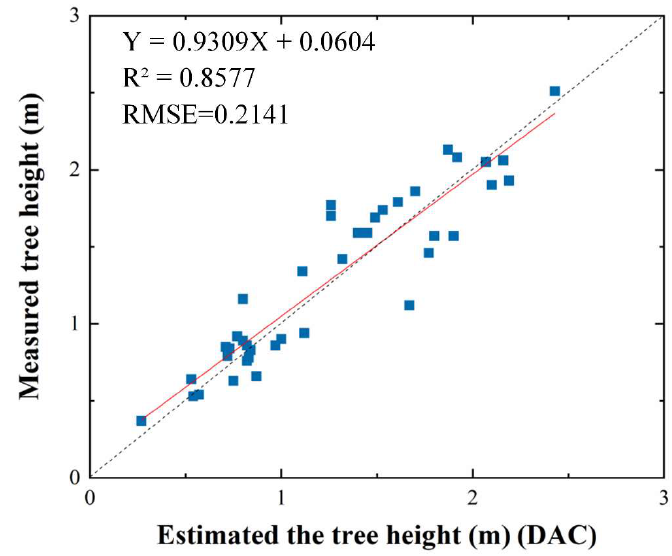
Figure 9. Tree-height accuracy verification; the blue points are the verification results of DAC in 2020.